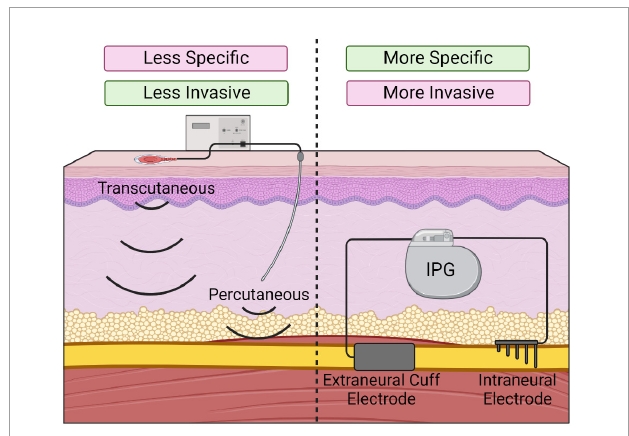
FIGURE3 Various types of peripheral nerve stimulation devices. Transcutaneous and percutaneous stimulation (Left) offer temporary and minimally invasive stimulation but are less specific. Implanted electrodes ( Right ; extraneural or intraneural) offer more specific nerve stimulation but require invasive